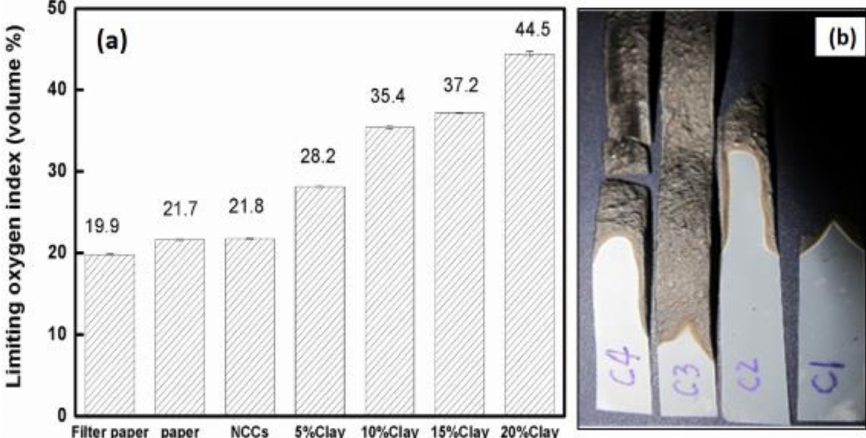
Figure 5. ( a ) Limiting oxygen index (LOI) of CNF / NC composites in comparison to printing and filter paper. ( b ) Photograph showing char formation for the composites containing (C1) 5%, (C2) 10%, (C3) 15%, and (C4) 20% of